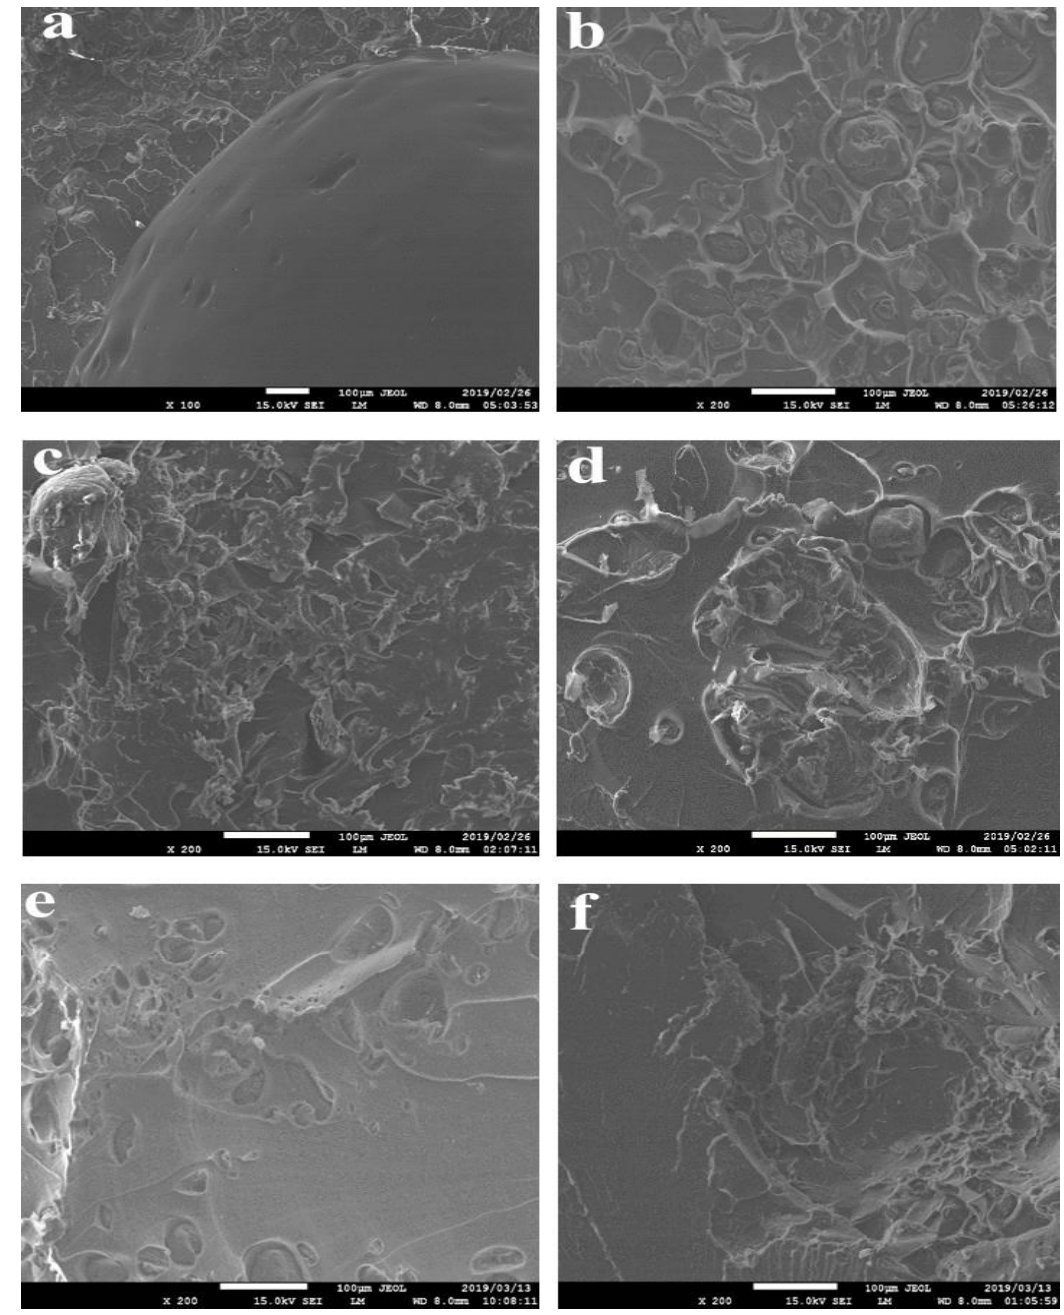
Figure 8. Scanning electron microscopy (SEM) fracture images. ( a ) 92% PLA–4% chitin–4% starch; ( b ) 92% PLA–8% chitin; ( c ) 92% PLA–8% starch; ( d ) 94% PLA–3% chitin–3% starch; ( e ) 94% PLA–6% chitin; ( f ) 94% PLA–6% starch.